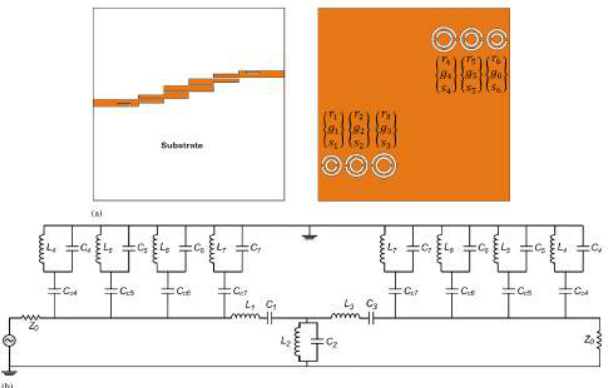
Figure 9: (a): Top and Bottom views of the optimized filter design, (b) : Correspondent equivalent circuit